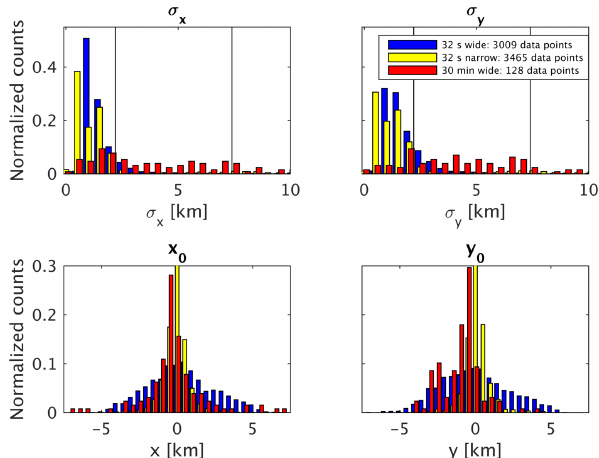
Figure 6. Histograms of the widths in x and y direction (top row) and centre locations (bottom row). For each figure, three histograms are shown. Yellow: 32s narrow beam, blue: 32s wide beam, red: 30min wide beam blue for 32 s integration period and in red for 30 min by aver- aging the spectra of the 32 s data set. The two black vertical lines indicate the 3 dB beam sizes at 85 km for the narrow (2.2 km) and wide beam (7.4 km), respectively. The bottom row shows the centre locations in x and y